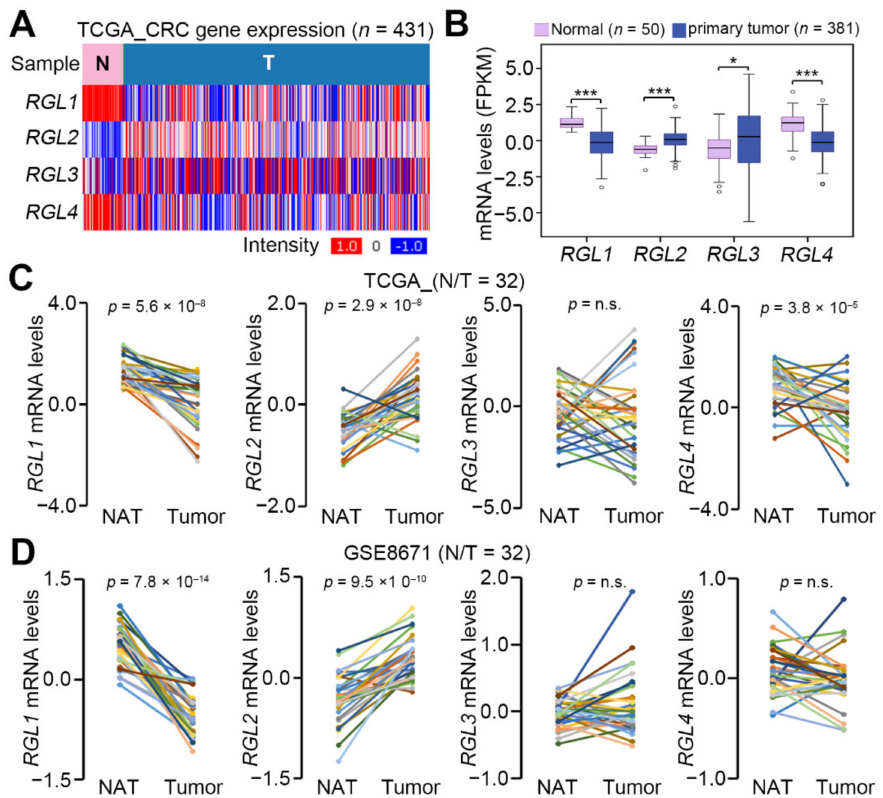
Figure 1. Ral Guanine Nucleotide Dissociation Stimulator Like 2 (RGL2) is upregulated in primary tumors compared to normal tissues derived from colorectal cancer patients. Heatmap ( A ) and boxplots ( B ) for the transcription profiling of RGL1, RGL2, RLG3, and RGL4 in the The Cancer Genome Atlas (TCGA) colorectal cancer database. The statistical significance was analyzed using a t-test. The symbols “*” and “***” represent p < 0.05 and p < 0.001, respectively. The mRNA levels of RGL1, RGL2, RLG3, and RGL4 in normal adjacent tissues (NATs) and primary tumors from the TCGA ( C ) and GSE8671 colorectal cancer patients ( D ). The statistical significance was evaluated by paired t -tests. The “n.s.” denotes not